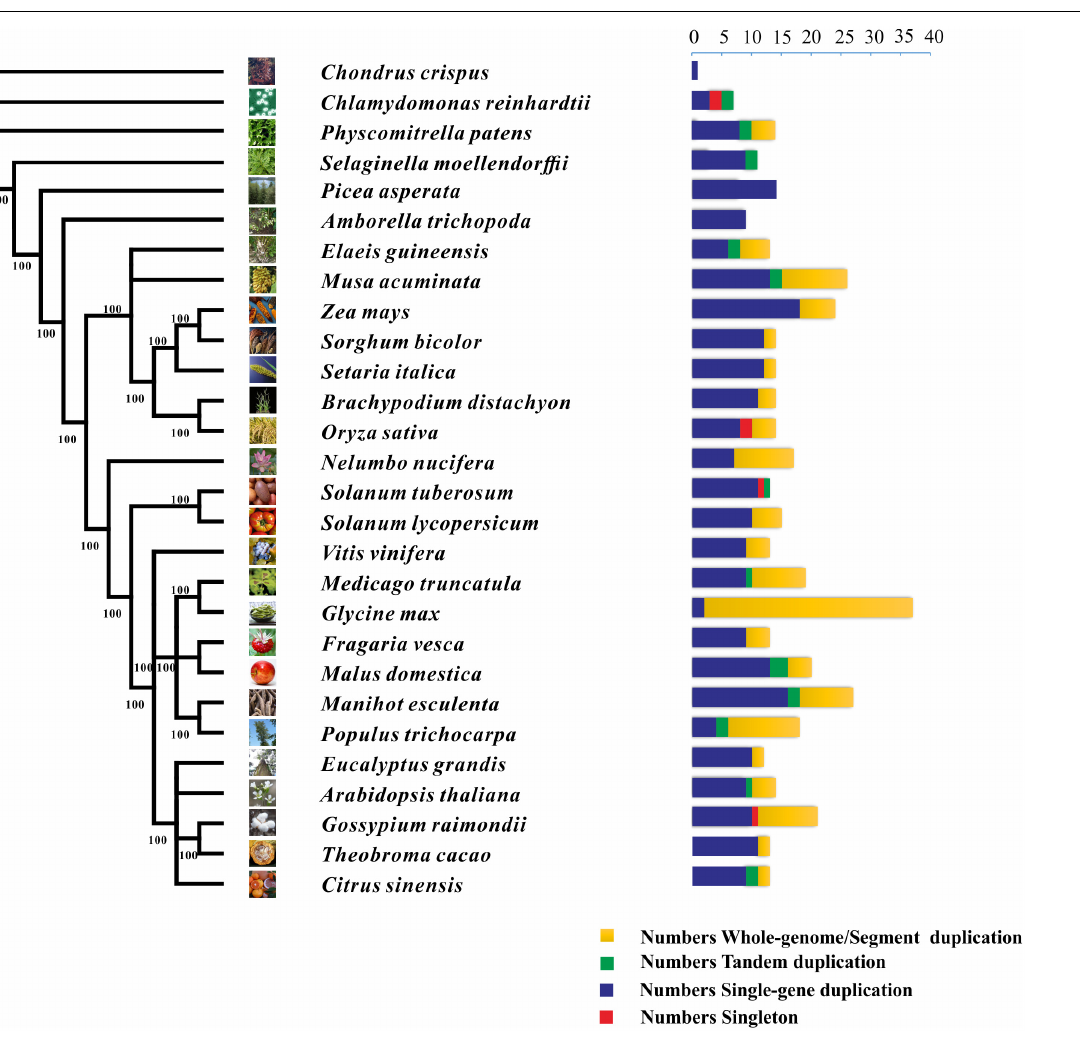
Frontiers in Plant Science |